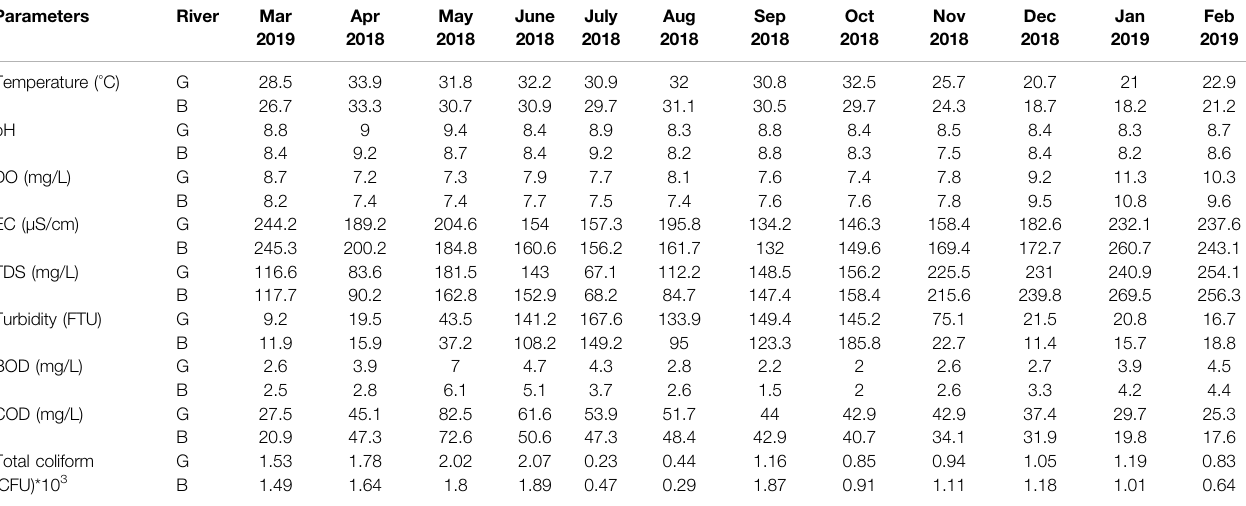
TABLE 1 | Physicochemical parameters in the downstream of Ganges (G) and Brahmaputra (B) rivers.